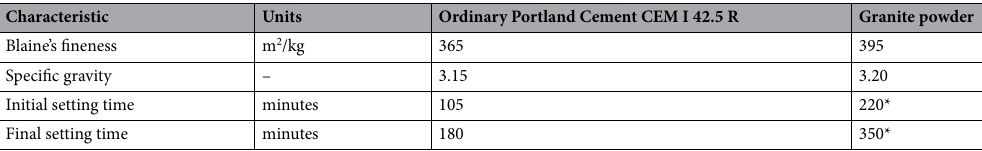
Table 1. Comparison of the physical properties of the cement and granite powder. *For cementitious composites with 30% of the cement replaced with granite